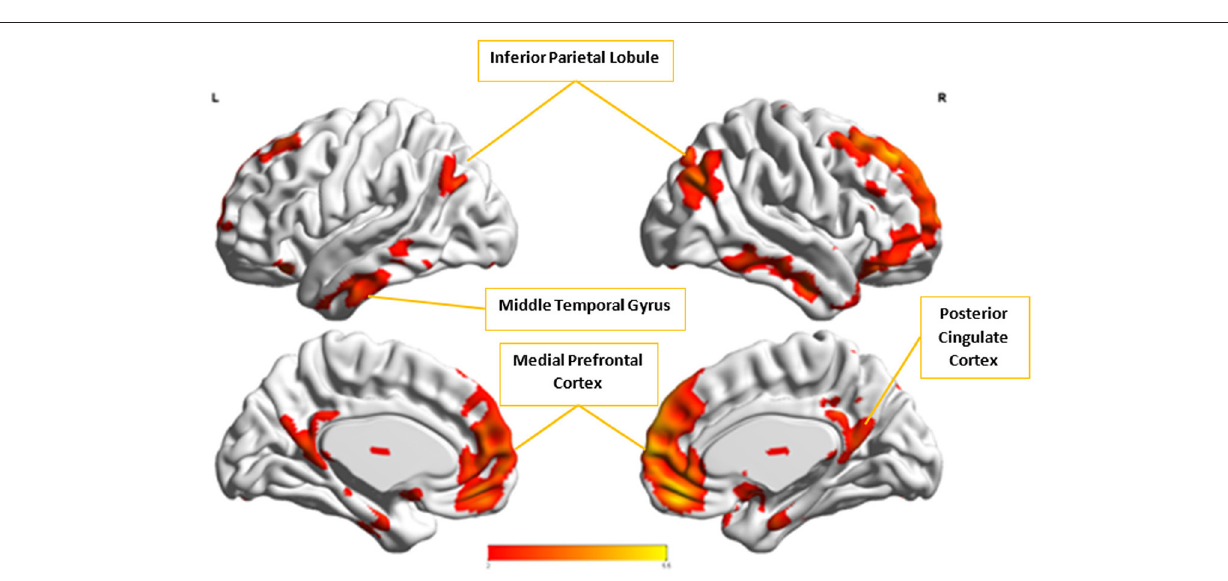
results, shown in the previous section, indeed support the above hypothesis. SOM visualizations provided along with spatial